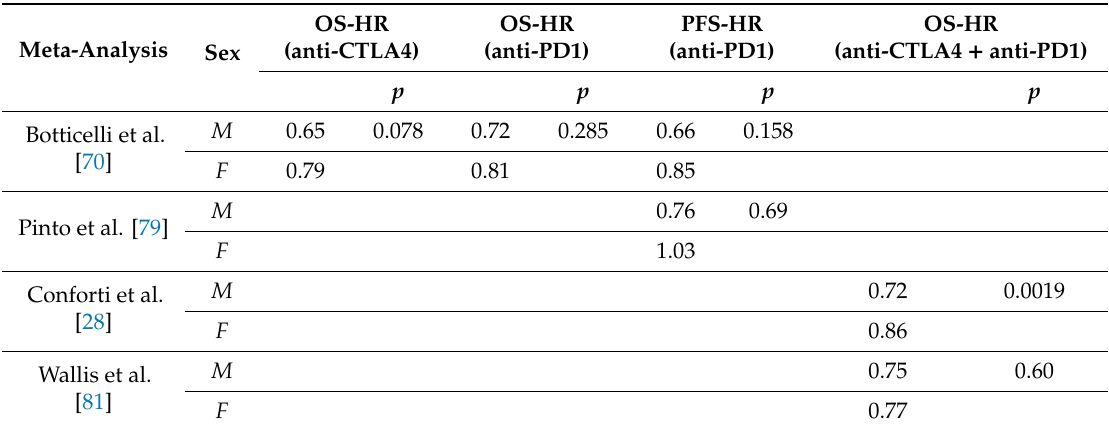
Table 2. Clinical outcome with immunotherapy according to the sex of patients (overall survival (OS), hazard ratio (HR), progression-free survival